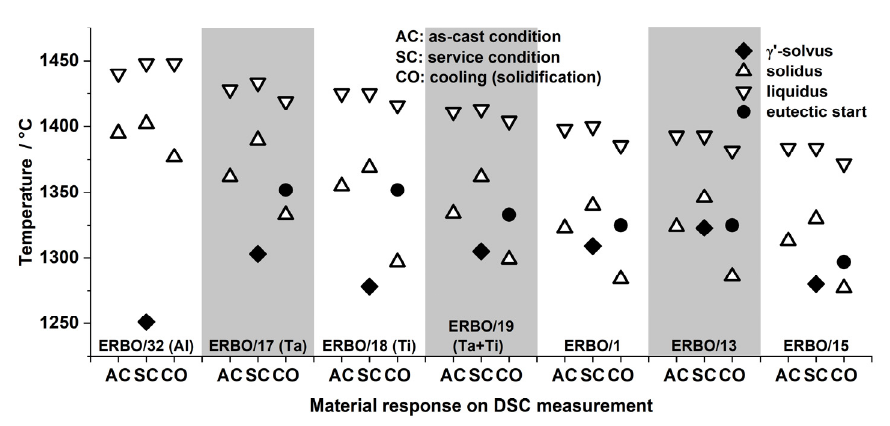
Figure 6. DSC results for the as-cast (AC), homogenized and aged state (service condition = SC), as well as solidification (cooling = CO) results from the single-crystalline alloys.